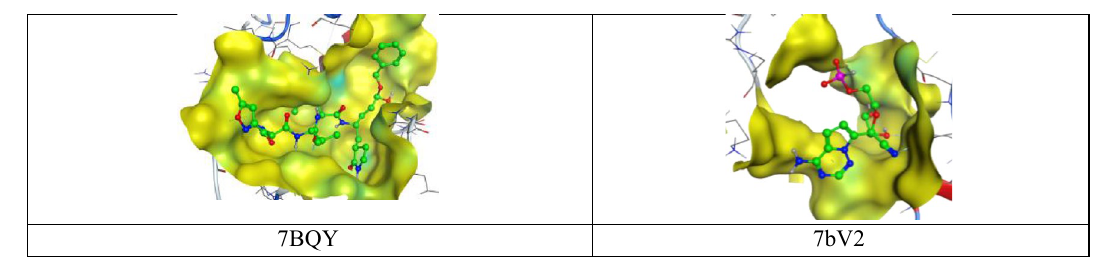
Fig. 2 High-resolution crystal structures of coronavirus targets explain the native ligands in the active pockets (PDB: 7BQY and